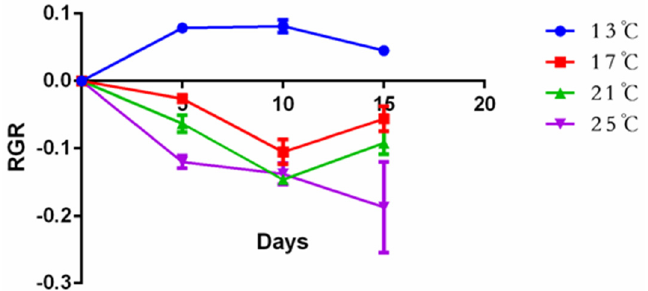
Figure 1. The relative growth rates of N. yezoensis thalli at different temperatures.